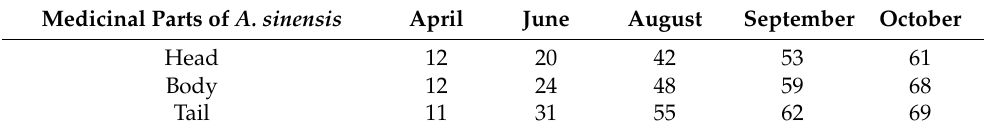
Table 4. The number of chemical compounds of A. sinensis in different parts in different periods. Medicinal Parts of A. sinensis